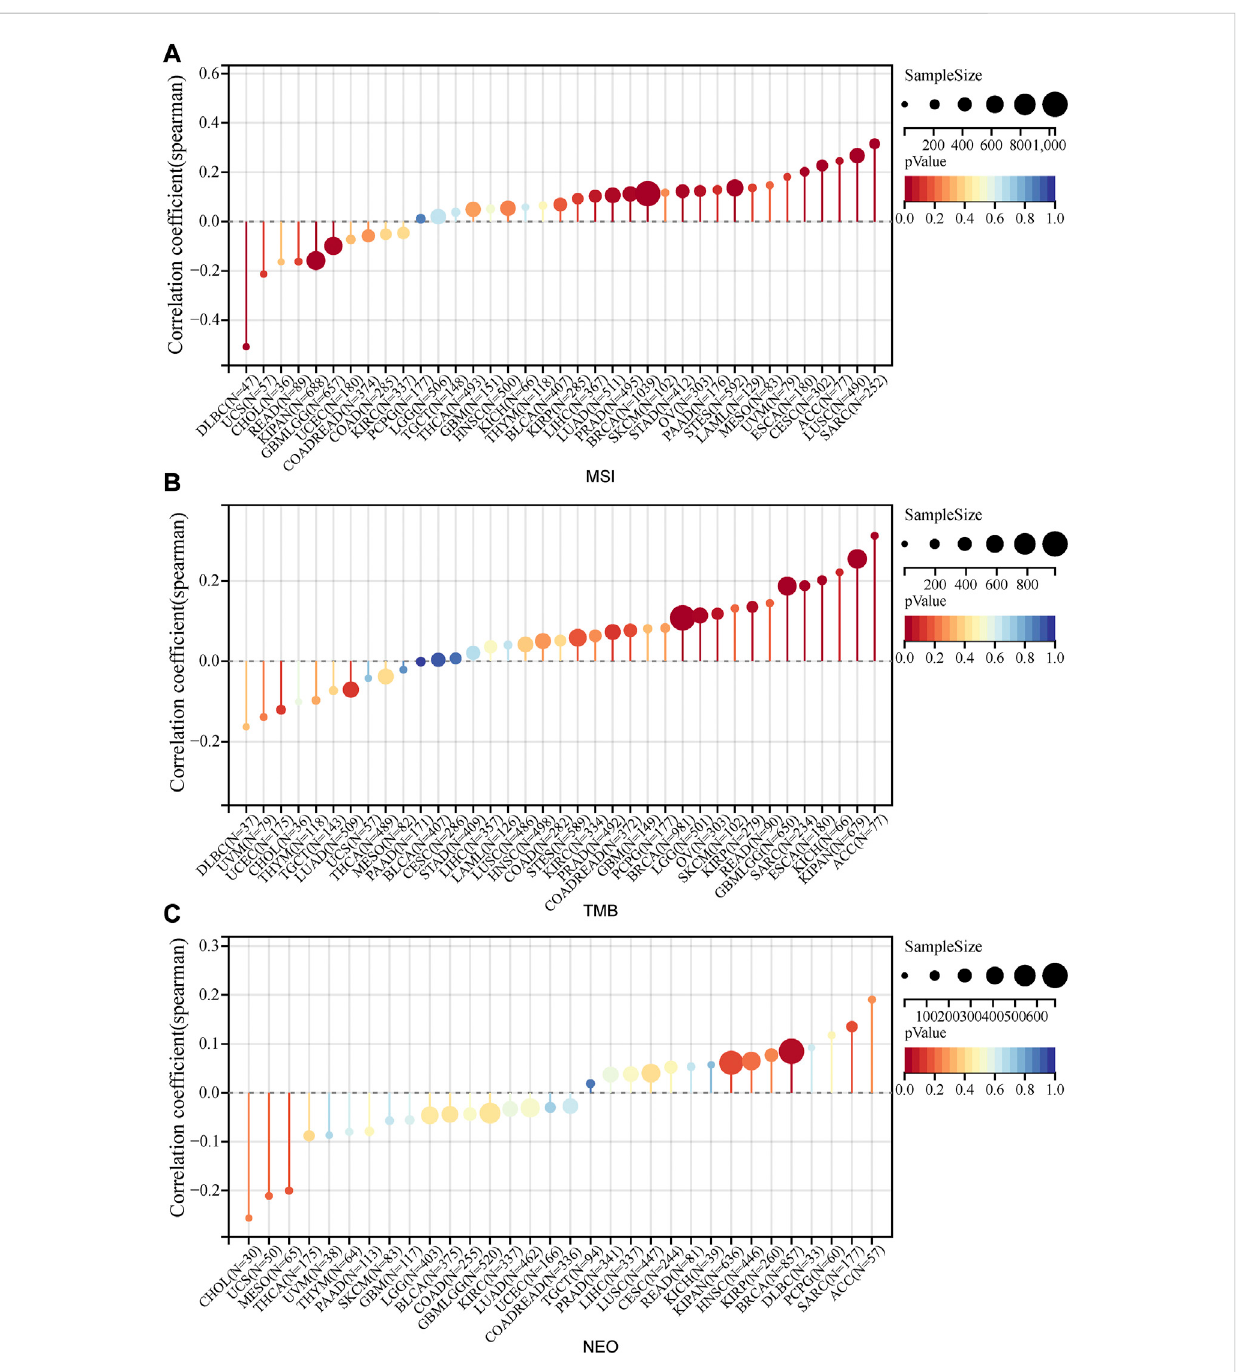
Lollipop plots of the correlation between PRR7-AS1 expression and MSI, TMB and NEO in pan-cancer. The correlation of PRR7-AS1 expression with (A) MSI, (B) TMB and (C) NEO. Correlation was tested by Spearman